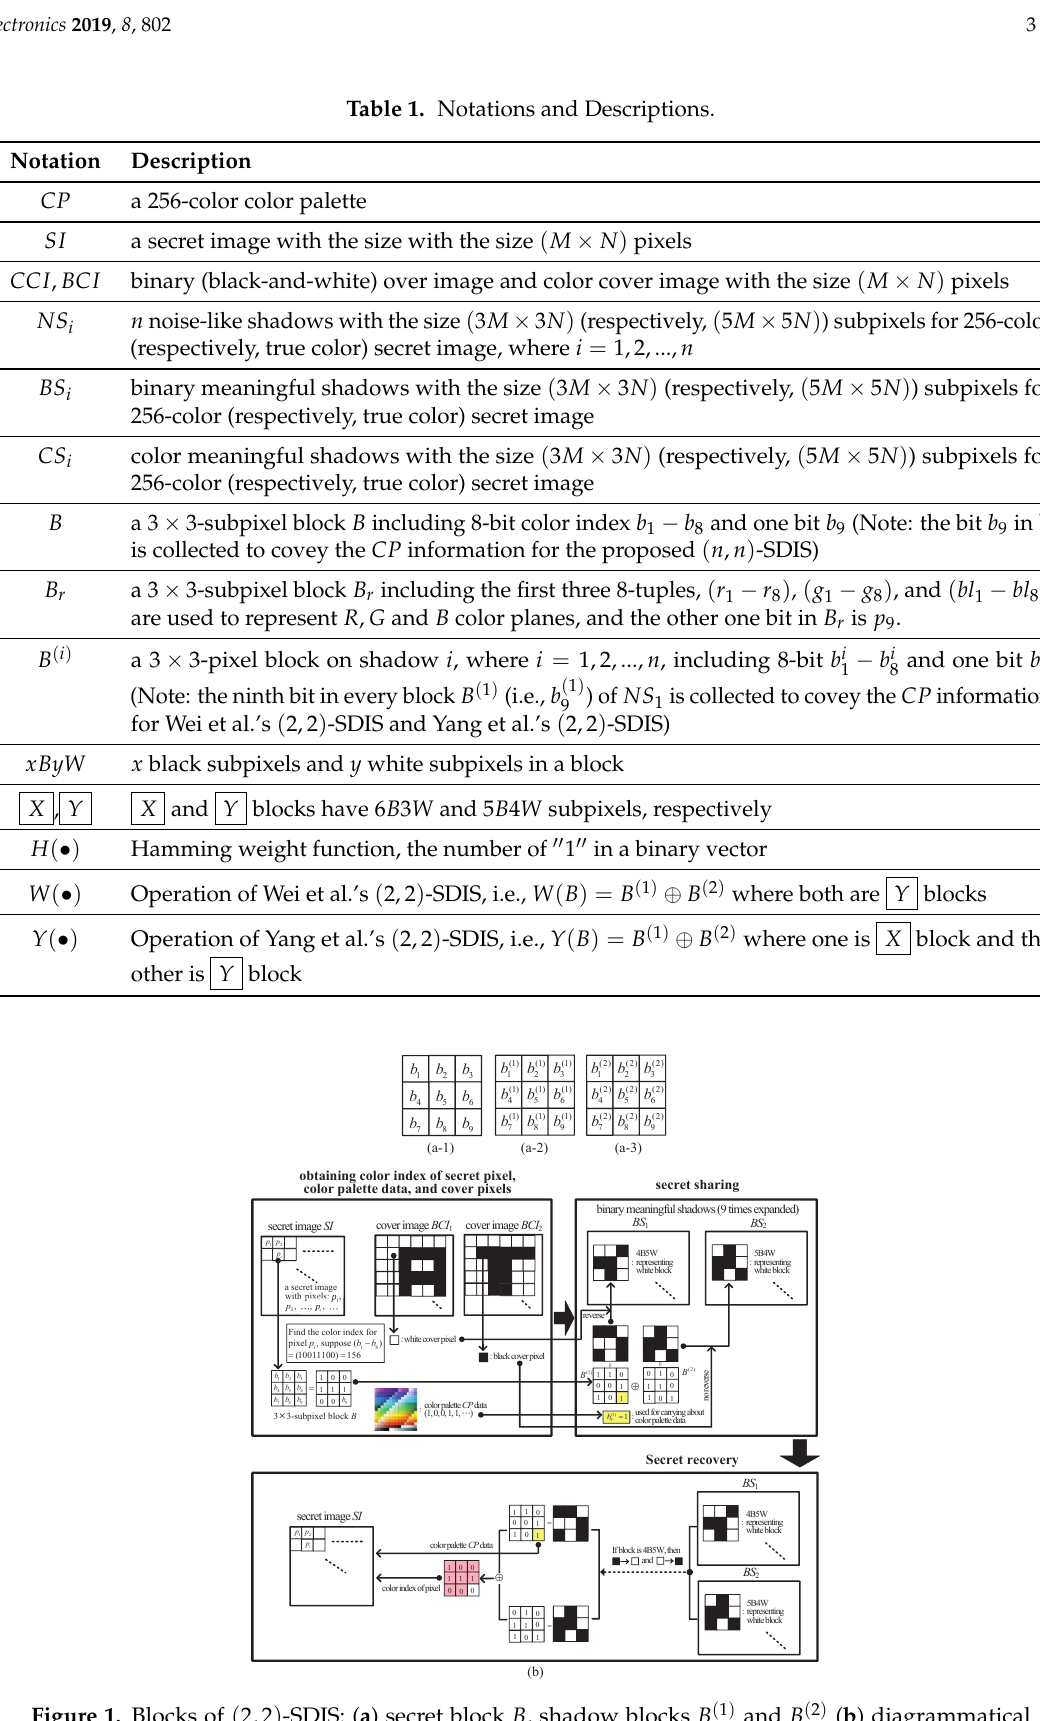
Figure 1. Blocks of ( 2,2 ) -SDIS: ( a ) secret block B , shadow blocks B ( 1 ) and B ( 2 ) ( b ) diagrammatical representation of Wei et al.’s ( 2,2 ) -SDIS with binary meaningful